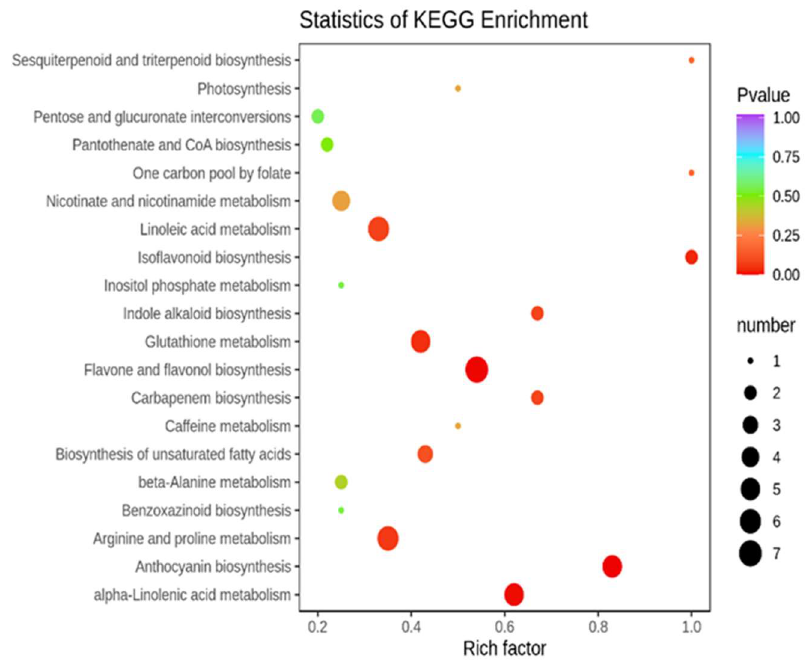
Figure 6. DAMs KEGG pathway enrichment between T1 and T2.